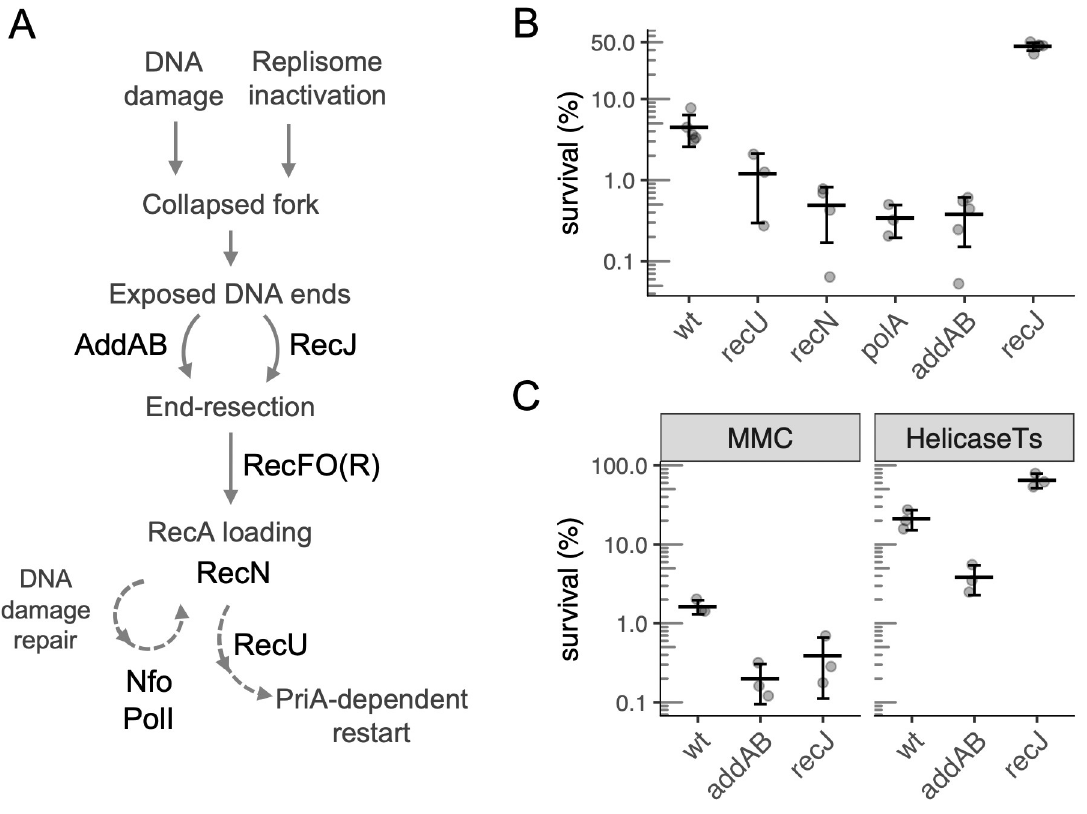
Fig 1. Pathways and genes involved in cell survival after arrest of DNA replication. A. General view of the roles of the DNA repair and recombination genes identified in the Tn-seq screen. The dashed arrows represent multistep pathways. B. Percent survival of wild type (strain JMA222) and recU (GP891), polA (LSF41), recN (LSF298), addAB (LSF253) and recJ (LSF200) null mutants after 3 h of replication arrest caused by HPUra treatment. Percent survival is relative to cell viability at the time of arrest. All mutants were statistically different from wild type, as assessed by two-sample t-tests (P < 0.025). C. Effects of recJ and addAB null mutations on cell survival following replication arrest due to treatment with the DNA damaging agent mitomycin-C (MMC) or inactivation of the replicative helicase (DnaC). Left panel: survival of wild-type (JMA222), Δ addAB (LSF253) and Δ recJ (LSF200) cells after 3 h of treatment with 0.33 μ g/ml of MMC. Right panel: wild-type, Δ recJ and Δ addAB cells carrying a dnaCts allele (LSF176, LSF274, and LSF326) were grown at permissive temperature (30˚C) to early exponential phase and shifted to non-permissive temperature (49˚C) for 4 h. Percent survival is relative to the population before treatment (left) or the temperature shift (right). The deletion mutants in both conditions were statistically different from wild type, as assessed by two-sample t-tests (P < 0.025). Throughout this work, error bars correspond to one standard deviation of the mean and each point is from an independent culture (biological replicates).